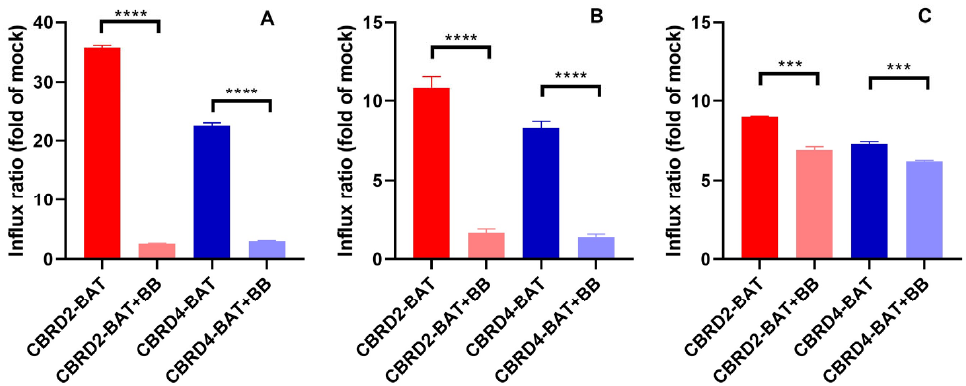
Figure 2. Influx ratio of dyes CBRD2-BAT (10 µ M) and CBRD4-BAT (10 µ M) in Uptake pH 5.5 ( A ) Uptake pH 7.4 ( B ) and in complete DMEM ( C ) into HEK-293-OATP3A1 compared to mock cells. Influx was determined as (mean RFU–relative fluorescence unit) with flow cytometry and inhibited with benzbromarone (BB) at 20 µ M and 80 µ M concentrations in Uptake buffer and DMEM medium, respectively. Significance of differences was estimated by t-test, **** <0.001; ***